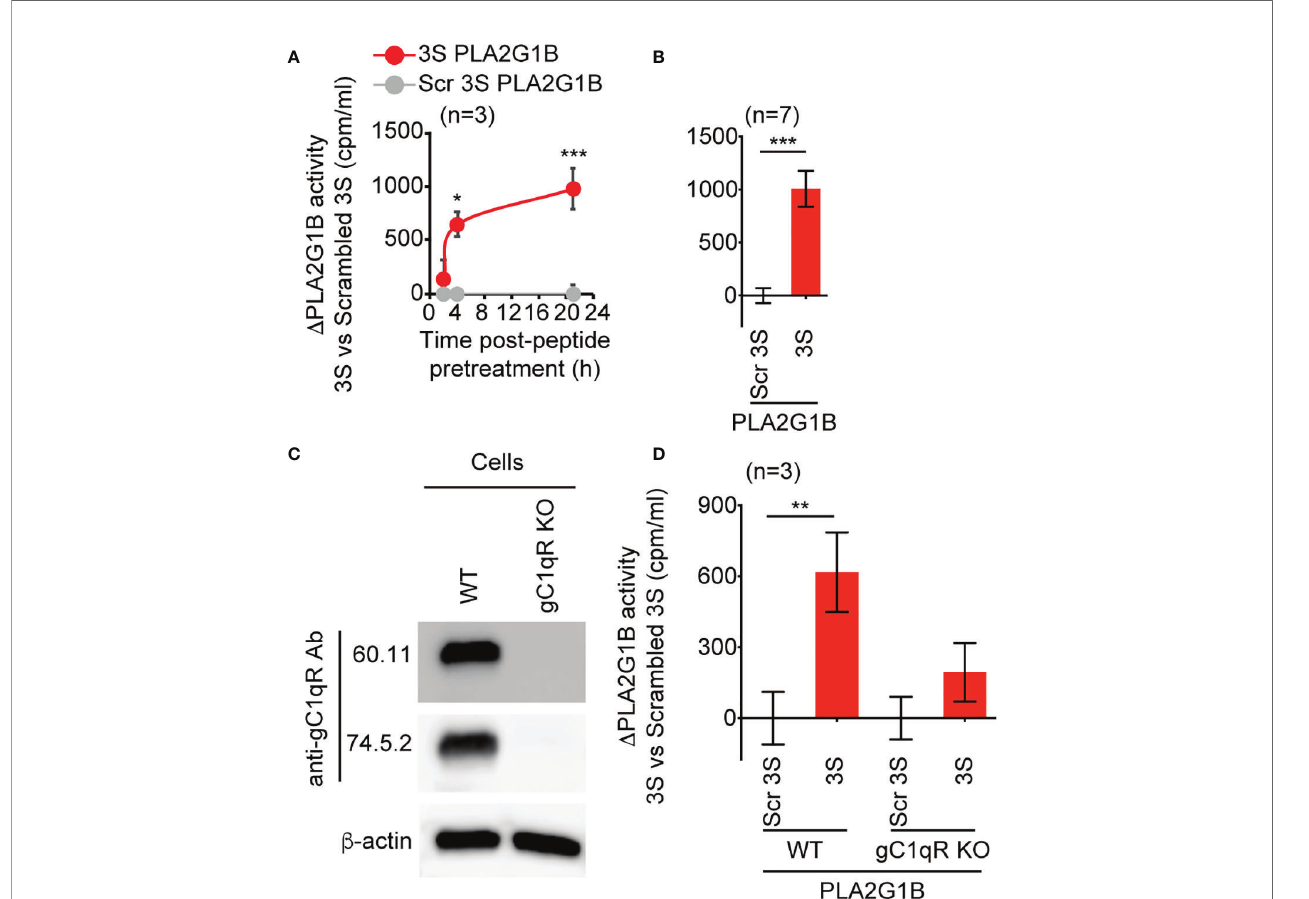
FIGURE 4 | The 3S/gp41 peptide regulates PLA2G1B activity in a gC1qR-dependent manner. (A, B) The HIV 3S peptide increases PLA2G1B activity on human Jurkat T cells. [3H]AA-labeled Jurkat T cells were pretreated with 3S gp41 (3S) or scrambled 3S (Scr 3S) peptides (11 µM) for various times (2, 4, or 21 h for A) or 21 h (for B) and incubated alone or with PLA2G1B (200 nM). (C) The gC1qR protein is detected in WT but not in gC1qR-de fi cient (gC1qR KO) Jurkat T cells by immunoblot. Two different anti-gC1qR mAbs were used (60.11 and 74.5.2), as well as anti-ß-actin mAb as an endogenous control of protein load. (D) The 3S peptide increases PLA2G1B activity on WT but not on gC1qR KO cells. WT and gC1qR KO [3H]-AA-labeled Jurkat T cells were pretreated with 3S or Scr 3S peptides at 11 m M for 21 h. Then, peptide-pretreated cells were incubated with PLA2G1B (200 nM) for 2 h. Results are expressed as the mean ± SEM of a pool of three (A, D) and seven (B) experiments performed in triplicate and as D PLA2G1B activity (activity with the 3S peptide minus that with the Scr 3S peptide). The level of [3H]AA released in the cell supernatant was quanti fi ed in cpm/mL. * p < 0.05, ** p < 0.01 and *** p < 0.001 by two-way ANOVA with Tukey ’ s correction for multiple comparisons (A, D) or an unpaired t-test (B)